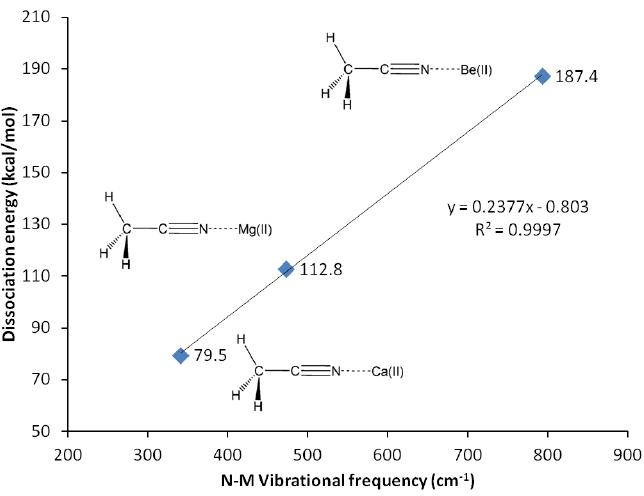
Figure 3. G4 Dissociation energy versus N-M vibrational frequency (in